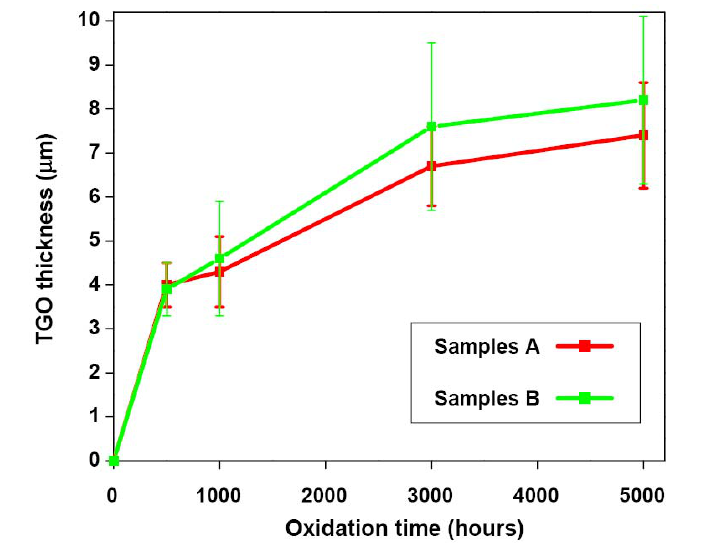
Figure 6 . Thickness of TGO layers of samples A and B after different periods of oxidation at 1,273